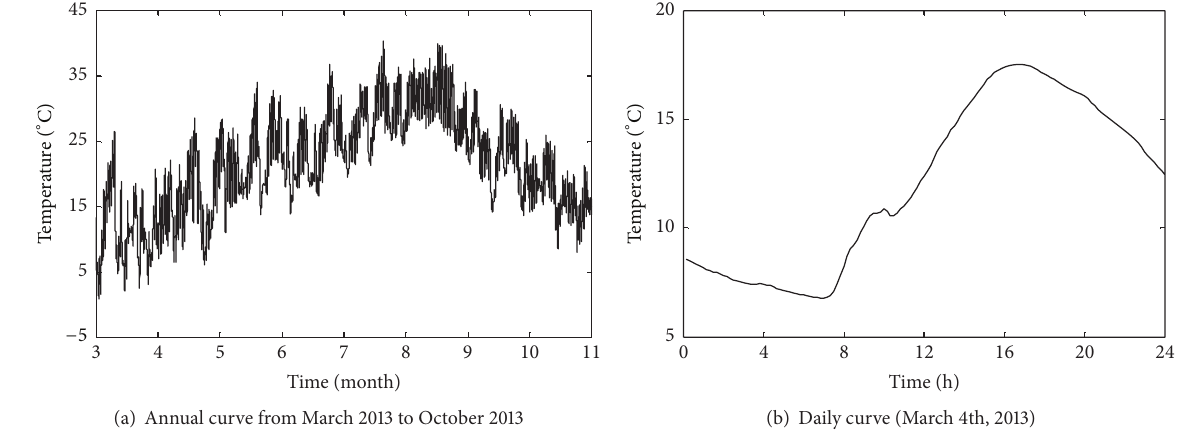
Figure 12: Time-history curves of temperature data 𝑇 1 .